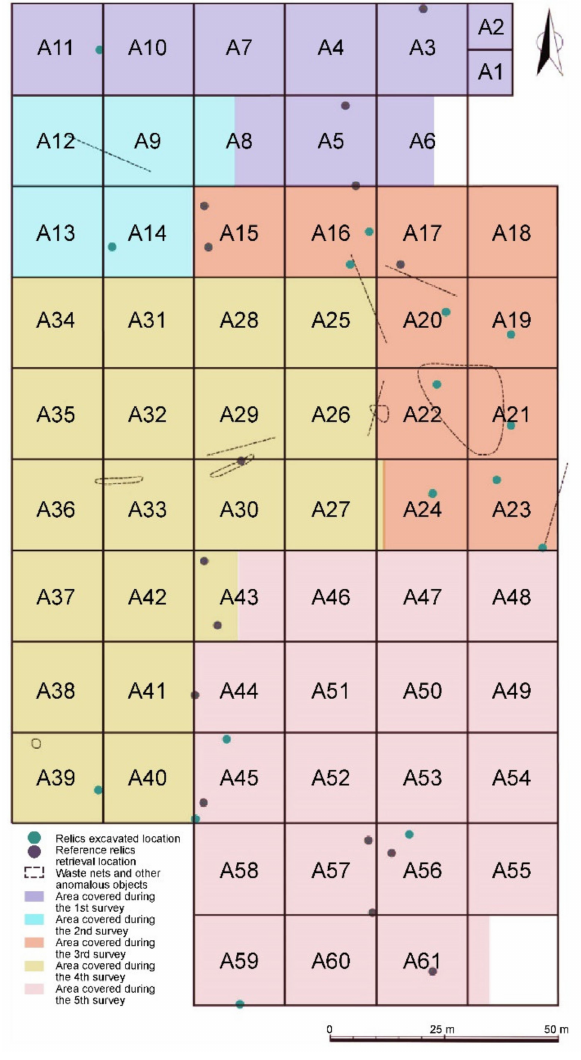
Figure 8. Survey chart of section A of the Nakwoldo underwater excavation